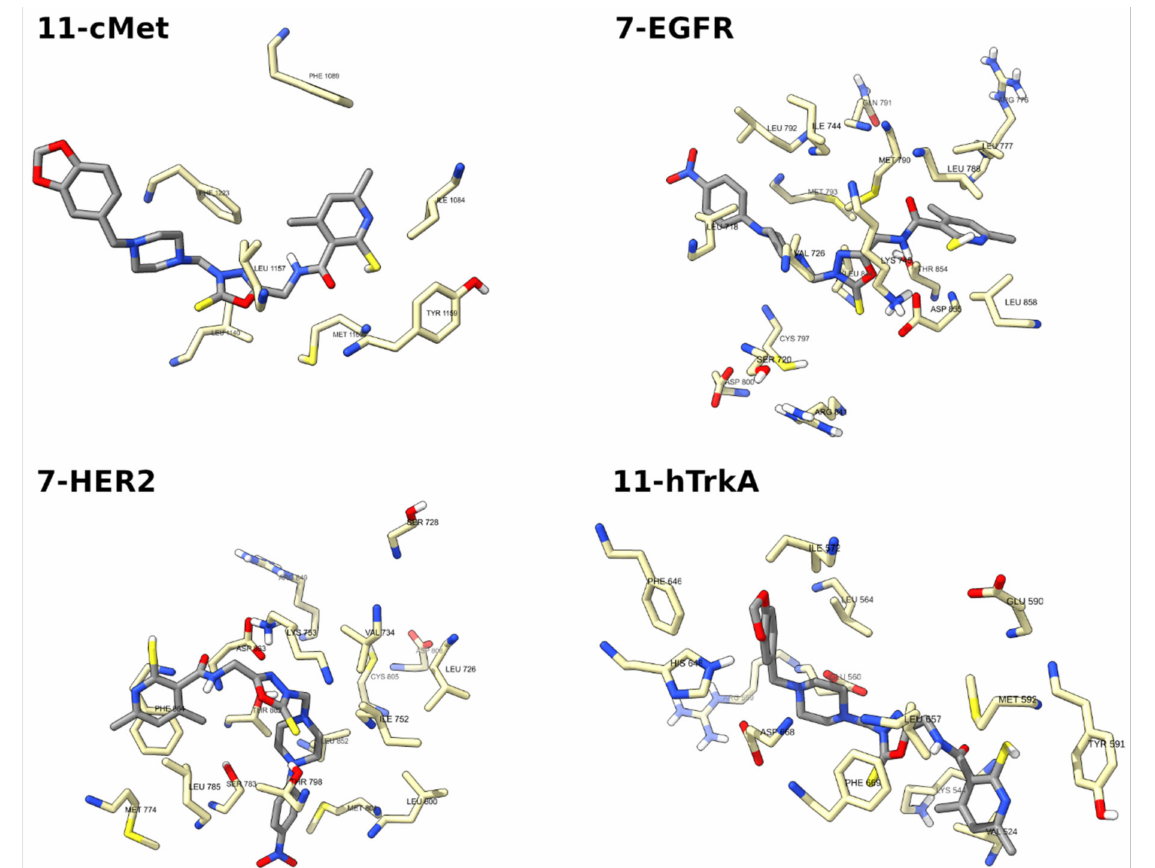
Figure 9. Binding modes of the ligand-receptor complexes. Only the best performing ligands (compounds 7 and 11 in our case) in terms of binding affinity are presented. Color coding: beige—carbon atoms of the amino acid residues, grey—carbon atoms of the docked ligand, blue—nitrogen, red—oxygen, yellow—sulfur,